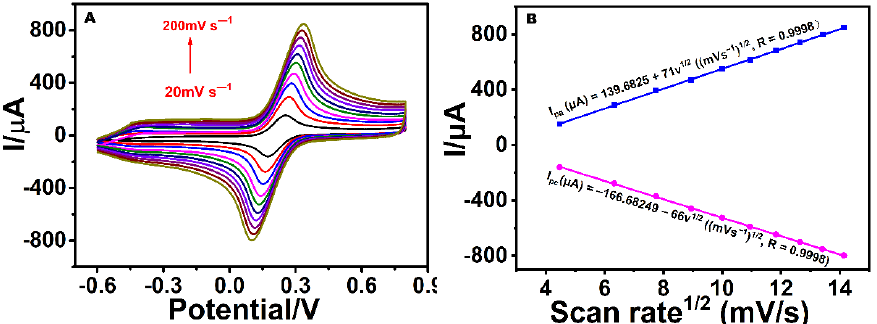
Figure 4. CV performance of AuNPs/PEDOT:PSS/GCE at various scan rates (20, 40, 60, 80, 100, 120, 140, 160, 180, 200 mV s –1 ) ( A ), the relationship between the square root of the scan rate and peak current ( B